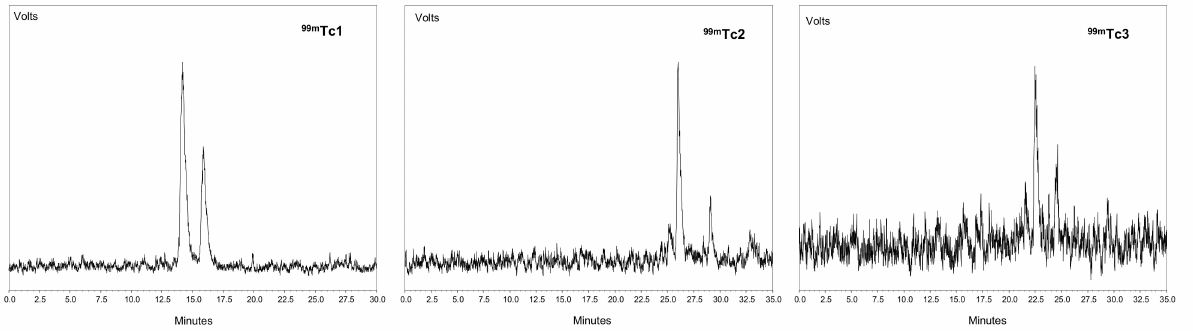
Figure 7. Chromatograms of the urine activity collected at 4h p.i. of 99m Tc1 , 99m Tc2 , 99m Tc3 collected by using the analysis conditions described in method 1 for 99m Tc1 and method 3 for 99m Tc2,3 . In vivo tumor uptake . The in vivo integrin targeting properties of the [ 99m TcN(PNP)]- labeled peptide were evaluated in M21 (integrin-positive) and M21L